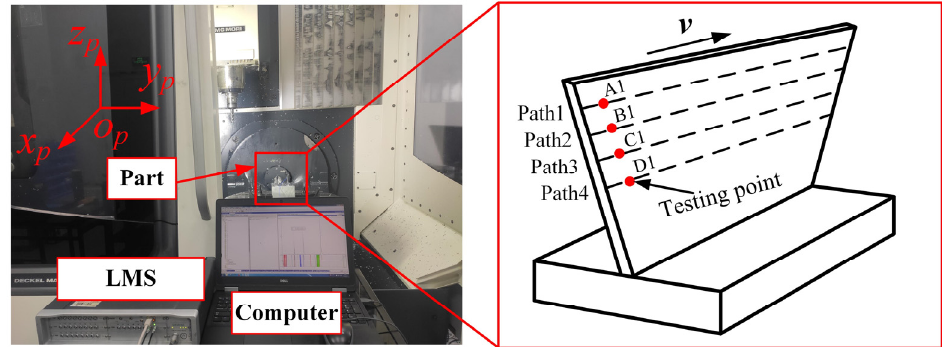
Figure 8. Experimental setup and testing points.